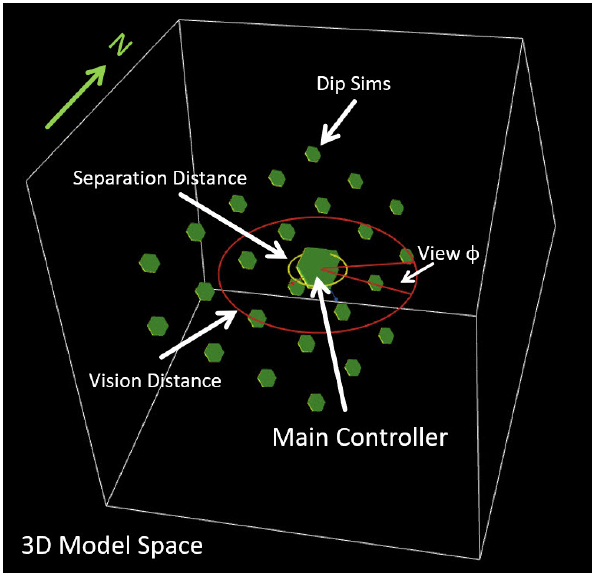
Figure 7. Components of the spatial agent-based model